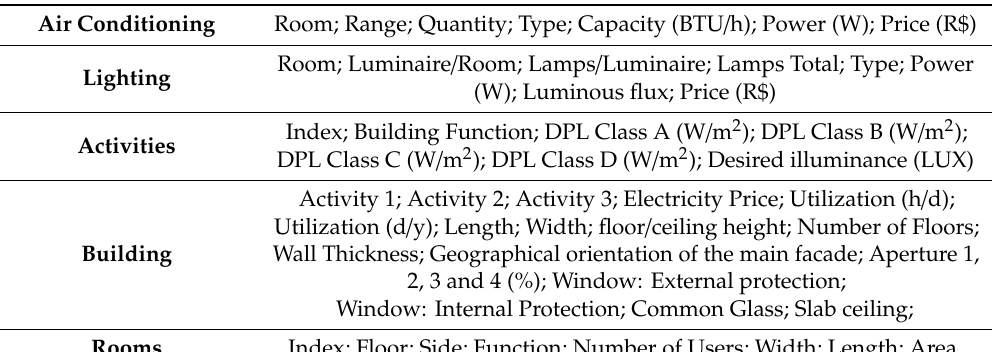
Table 1. Required data in each input file of the proposed